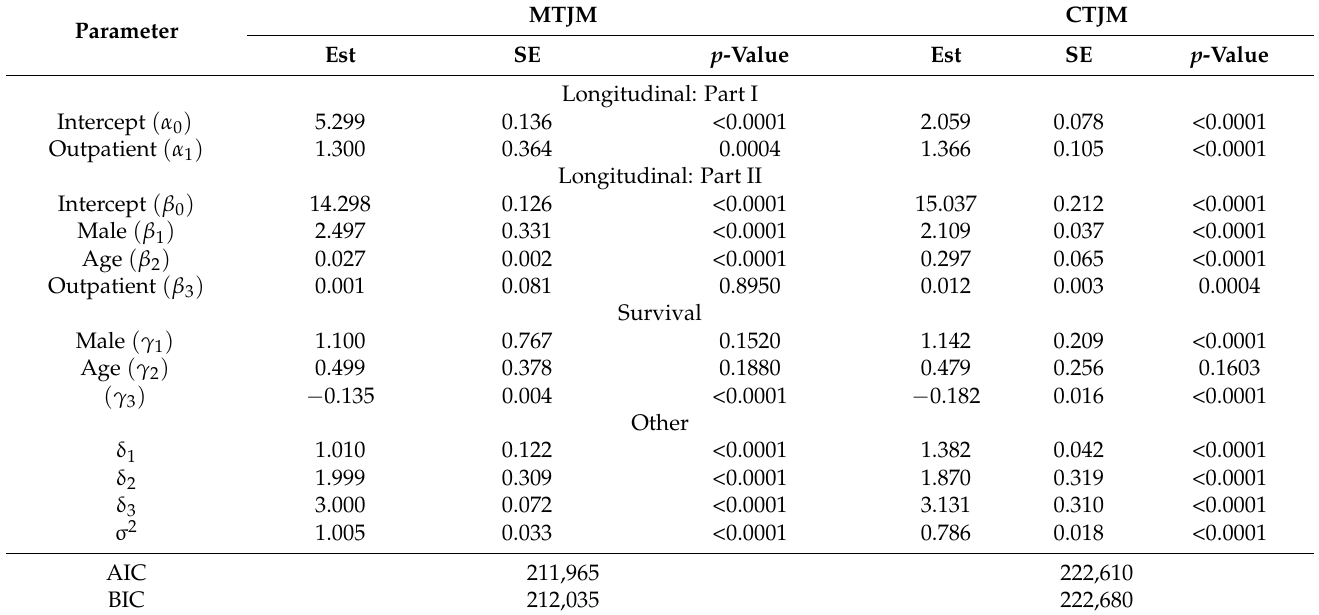
Table 7. Summary of the MTJM and CTJM fitted to the HDK